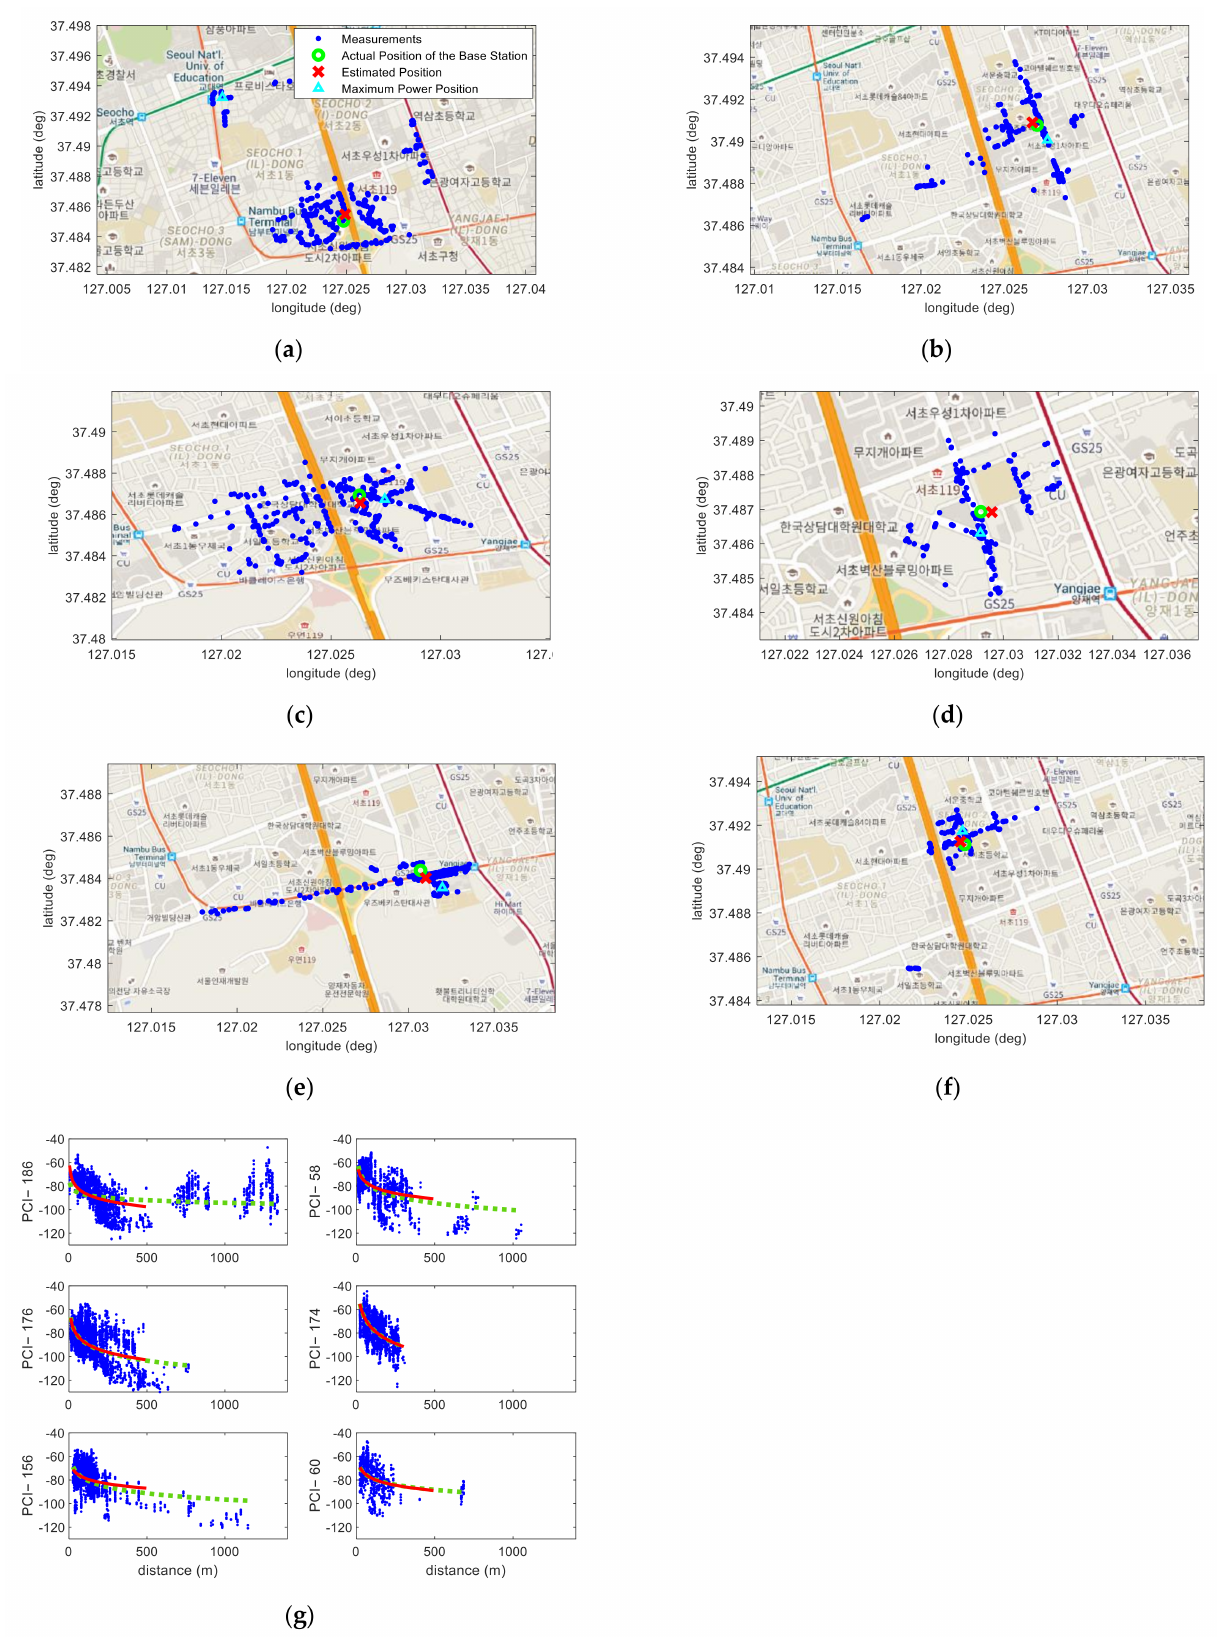
Figure 8. Results of base station positioning and SPMing. ( a ) PCI–186; ( b ) PCI–58; ( c ) PCI–176; ( d ) PCI–174; ( e ) PCI–156; ( f ) PCI–60; ( g )